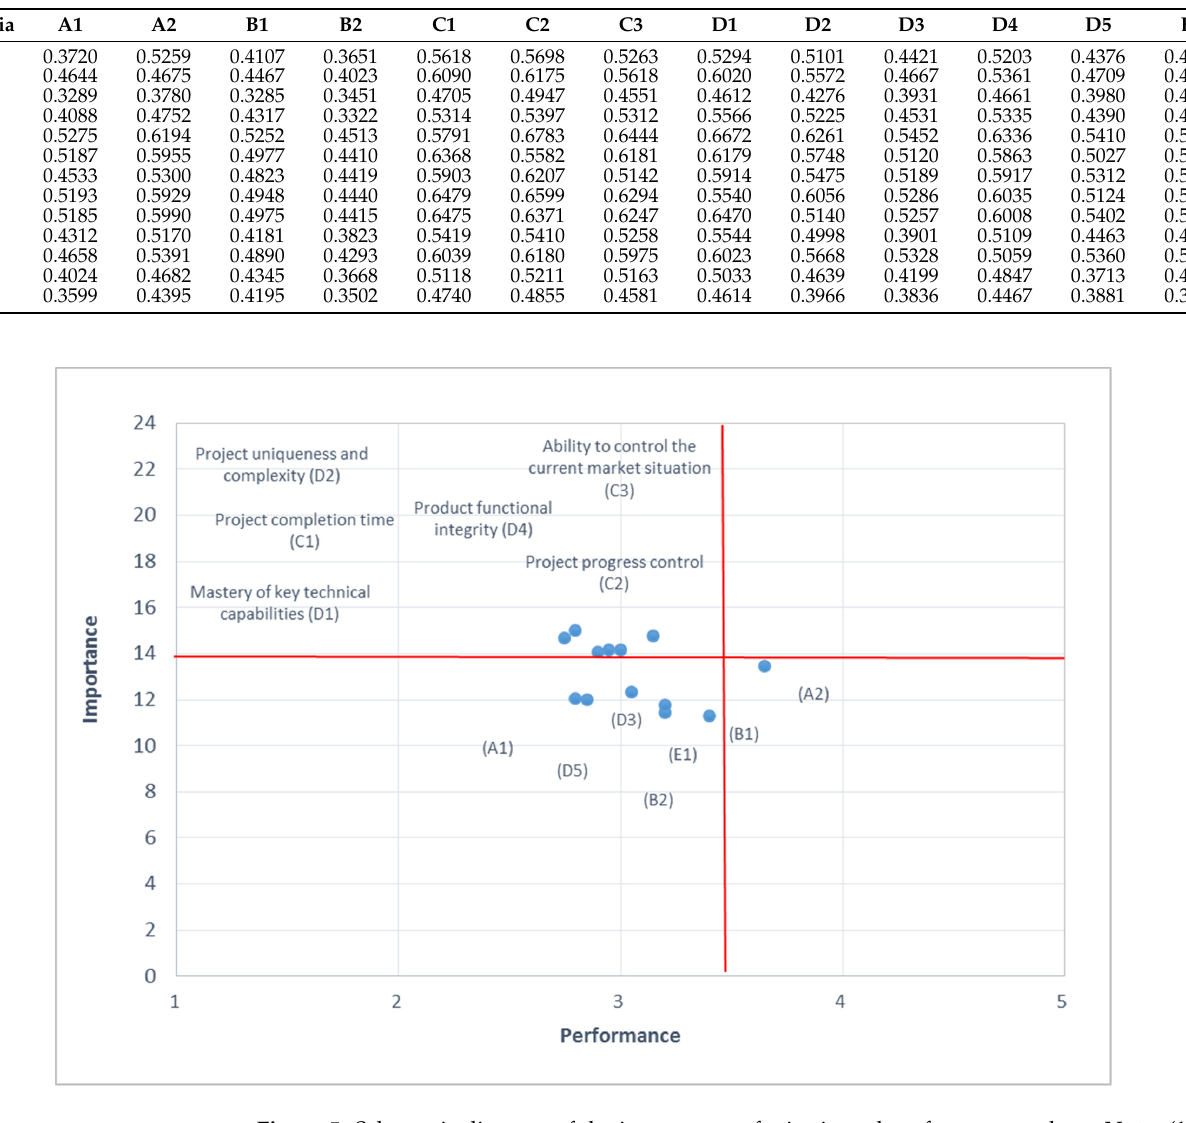
Table 10. Total influence matrix that determines the mutual influence relationship among key influence criteria.